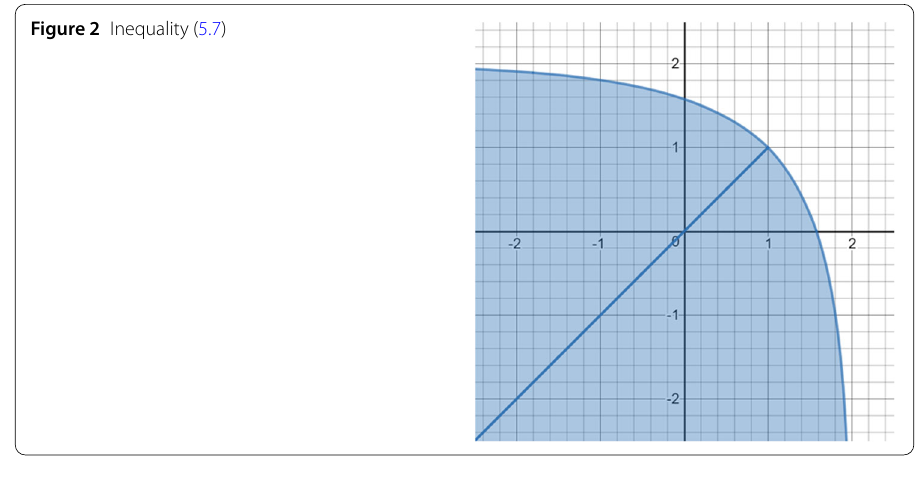
Figure 2 Inequality